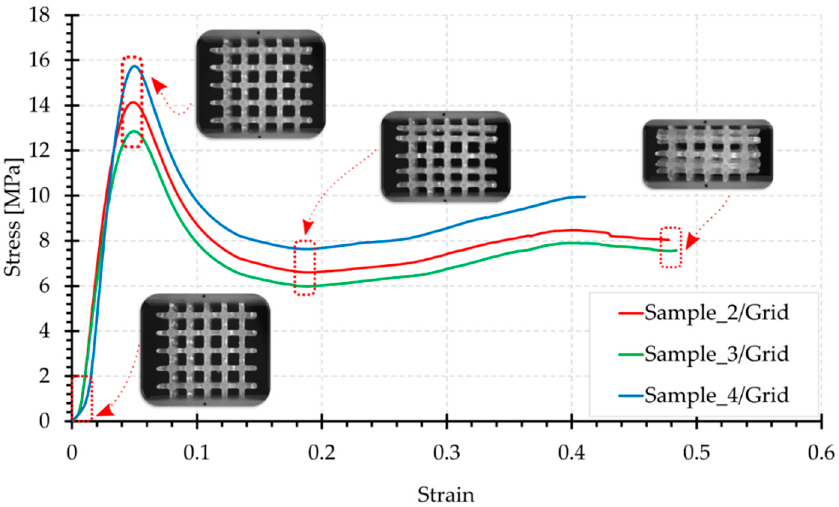
Figure 6. Compression curve for the Grid structure with photographs of the topology at selected test phases.